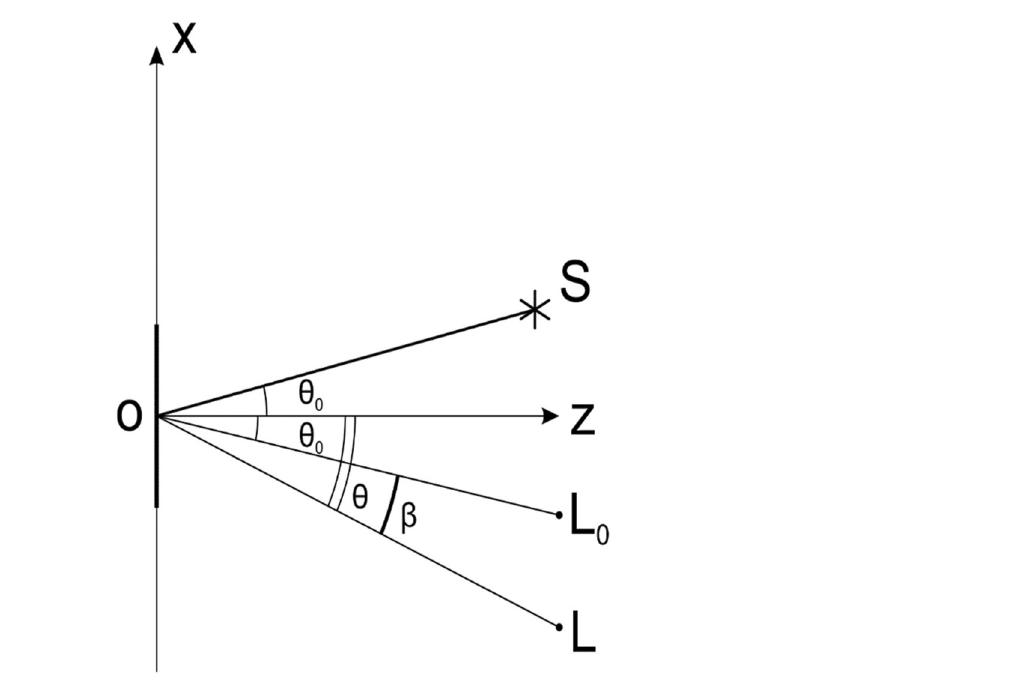
Figure 3. Scheme of observation at small diffraction